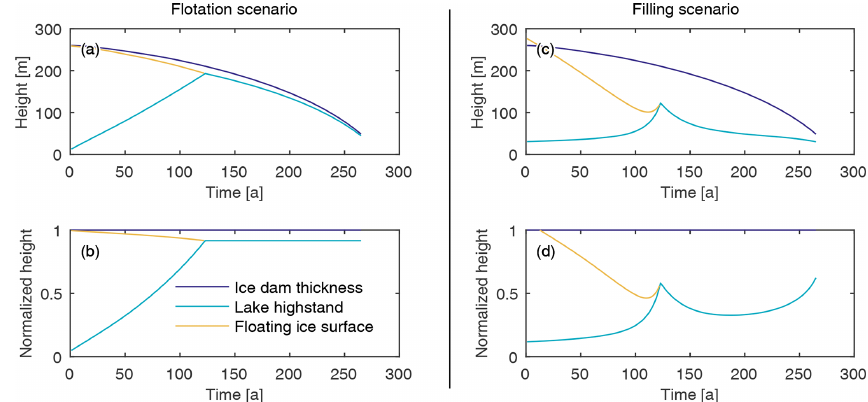
Figure 10. Time series of the ice dam elevation, lake highstand (peak water surface), and floating ice surface elevation at lake highstand for the (a) flotation and (b) filling scenarios. In panels (c) and (d) , the values for height are normalized using the ice dam thickness as a measure of